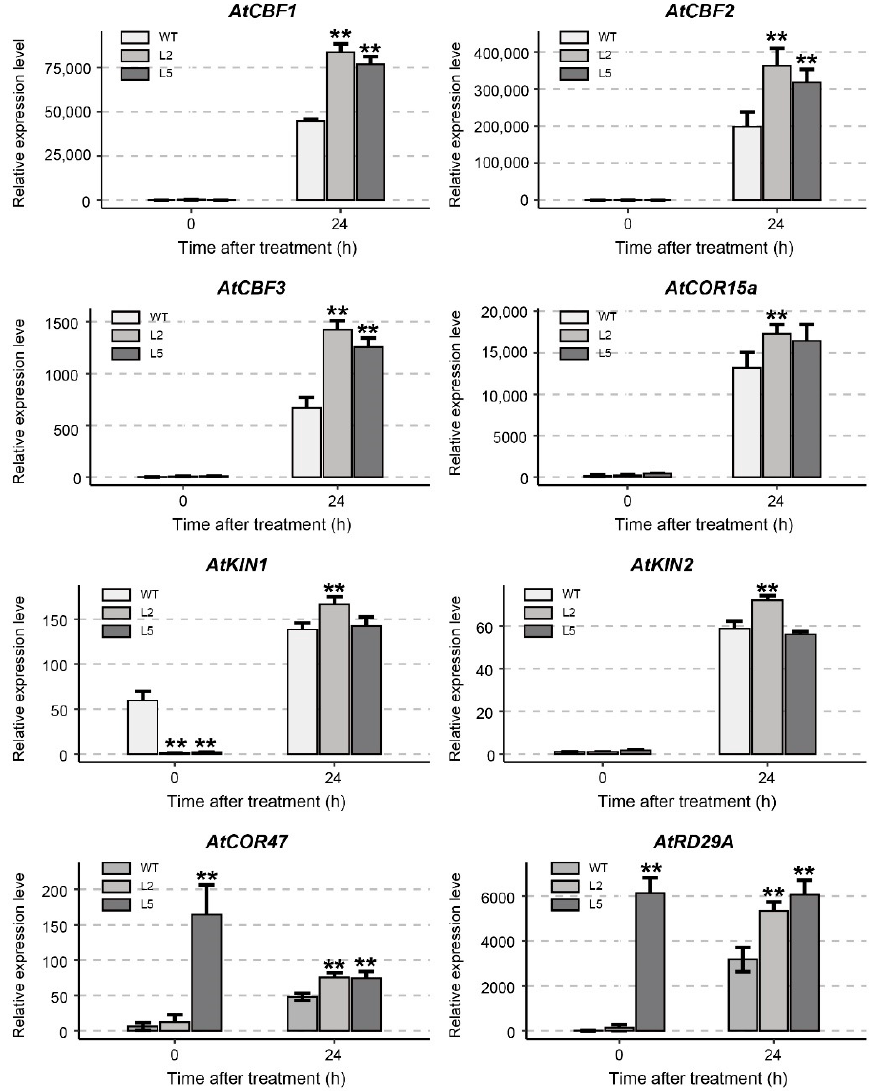
Figure 9. Expression analysis of cold-responsive genes in transgenic lines and WT plants before and after cold treatment. Each experiment was repeated three times, with the bar representing the standard error (SE). Asterisks indicate a significant difference from the WT plants under the same temperature condition at p < 0.01 as determined by a t -test.